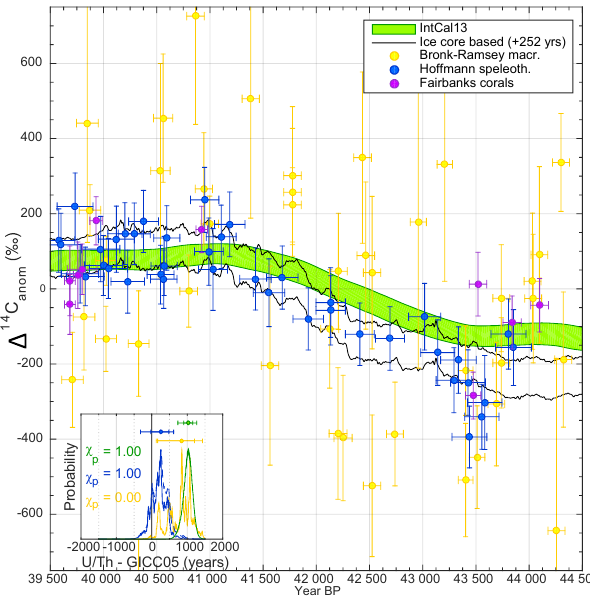
Figure 9. Close-up of measured and modeled (cid:49) 14 C anomalies be- tween 21 and 23kaBP. The thin grey line shows modeled atmo- spheric (cid:49) 14 C from the ice-core stack on the GICC05 timescale. The bold black and dashed red lines show the modeled atmo- spheric and ocean mixed layer (cid:49) 14 C curves after synchronization to the 14 C records (yellow: Lake Suigetsu; blue: Hulu Cave; purple and white: corals. The inset panel shows the PDF of the inferred timescale difference between GICC05 and the combination of all 14 C records. The black line is based on using only the modeled at- mospheric (cid:49) 14 C. The red dashed line is based on comparing coral and speleothem data to the modeled mixed layer (cid:49) 14 C and Lake Suigetsu data to modeled atmospheric (cid:49) 14 C. The green line shows modeled (cid:49) 14 C based on geomagnetic field changes.